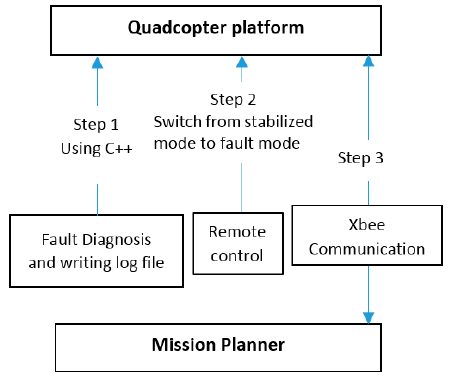
Figure 3. Experimental procedure.